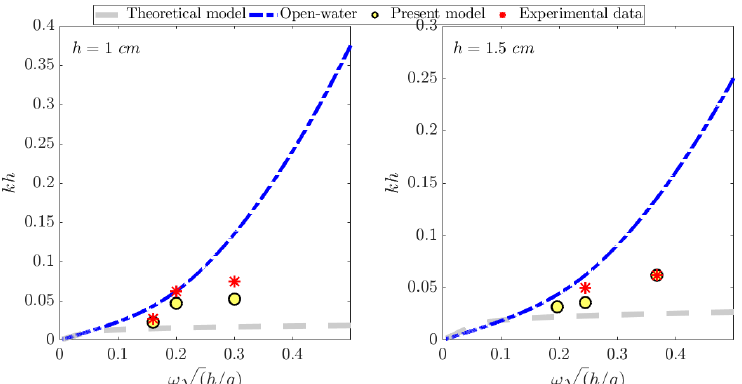
Figure 15. Dispersion curves of waves propagating in the freshwater ice (dashed curve and markers) and open-water conditions (dash-dotted blue curve). Experimental data are taken from [53]. The dashed curve is constructed using Equation (5).